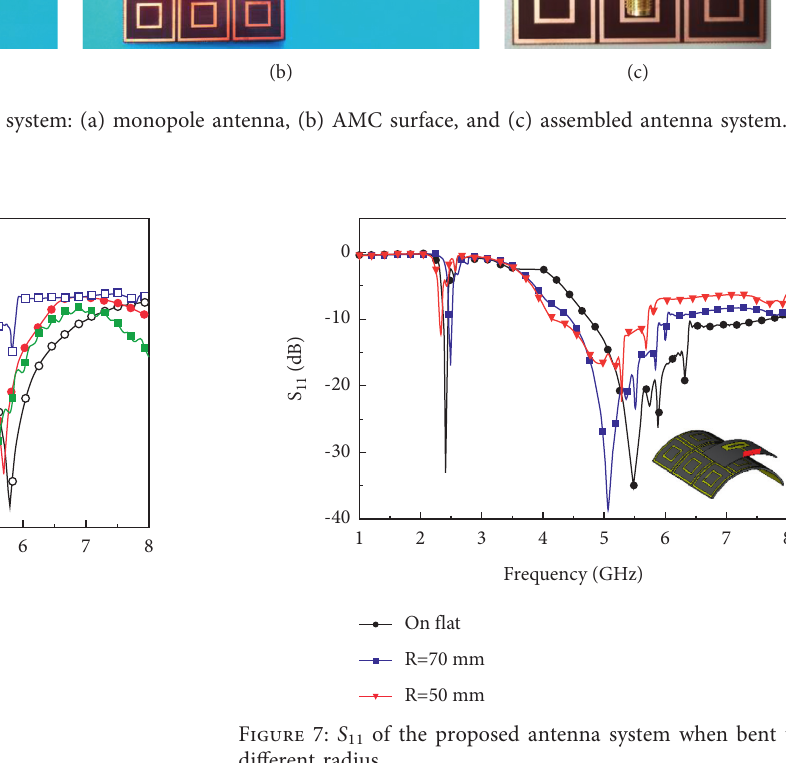
11 for the funnel-shaped